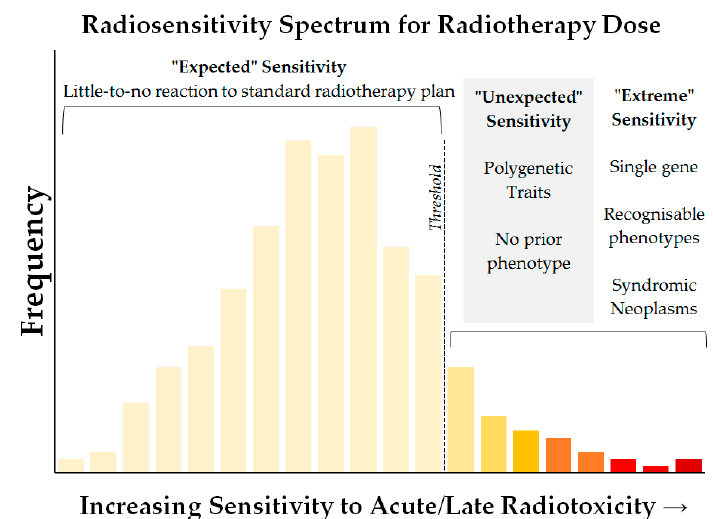
Figure 2. The concept of a radiosensitivity spectrum. Like other polygenetic traits, the true degree of radiosensitivity is expected to cover a wide spectrum rather than a clear bimodal distribution of sensitive and insensitive individuals, even though a binary classification may be apparent for a given clinical endpoint. Given that most acute/late reactions to radiotherapy show threshold responses and these are used to guide dose planning and prescription, sensitivities below the effective threshold for a given clinical toxicity endpoint would be expected to show little-to-no reaction. The patients that do show significant reactions would include those which show extreme sensitivity that might be caused by an inherited single-gene trait, and which might show a recognizable phenotype that might warn of an extreme response. The remaining reactions occur in individuals with no prior phenotype, whose sensitivity was unexpected and is likely a complex polygenetic trait. A singular spectrum of generic radiosensitivity is only an illustrative concept, given the divergent and bimodal expressions of different toxic reactions observed in the clinic, but at the cellular level it can be demonstrated using functional assays and for particular endpoints with careful assessment of reaction grades [7].